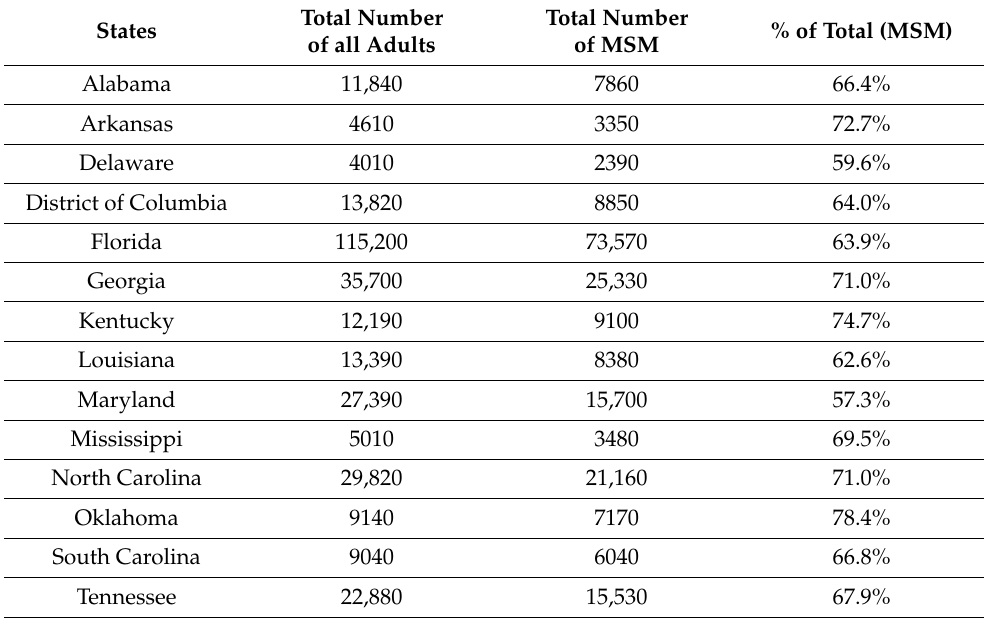
Table 1. Estimated number of MSM with PrEP indications in the South by transmission-risk group,